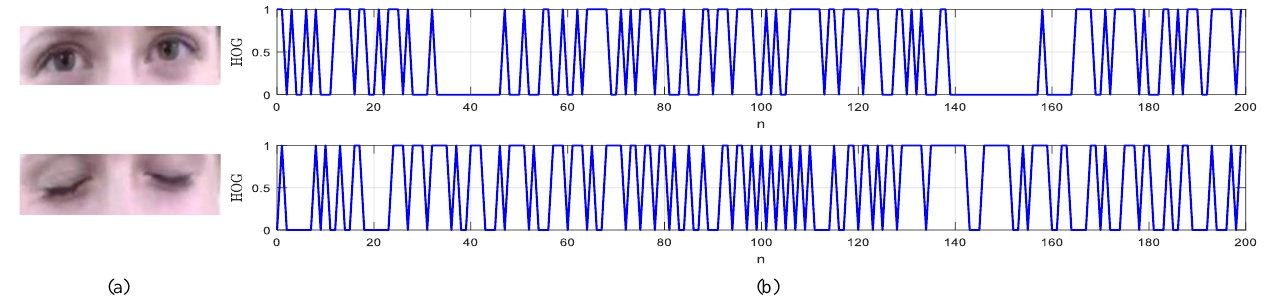
Figure 7. 2D visualization plots for the improved HOG descriptor of the HOG features extracted from two eye region snapshots: ( a ) input eye region image and ( b ) binarized HOG descriptor based on orientation shift.